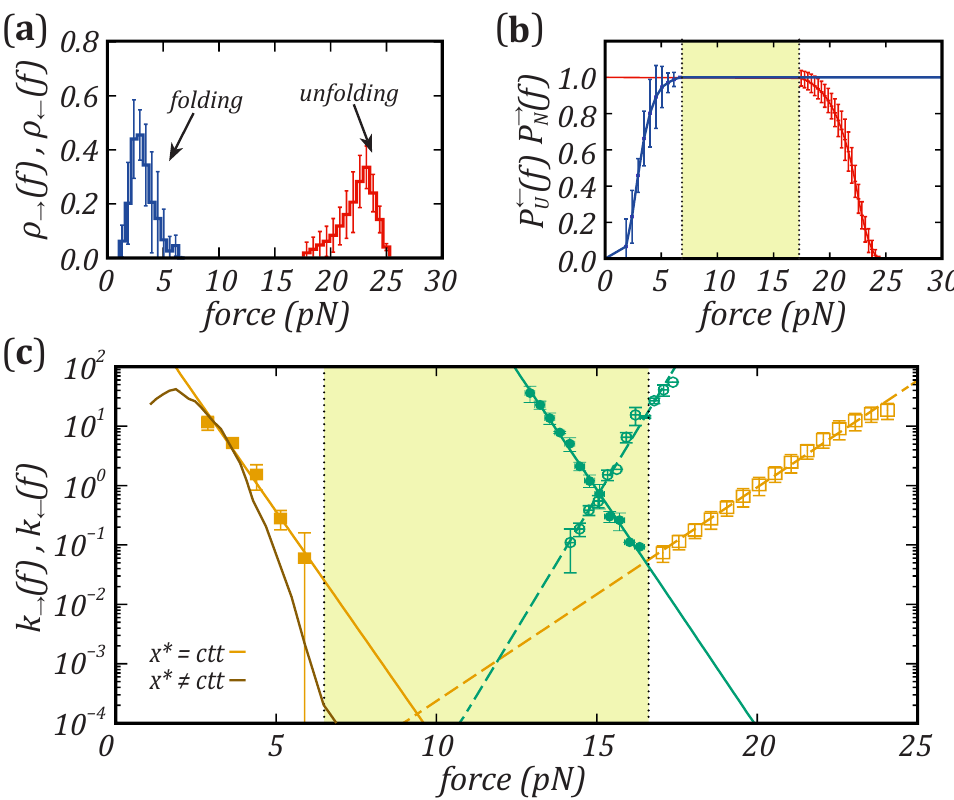
Figure 3. Pulling experiments in barnase at room temperature (298K). ( a ) Barnase unfolding and ( f ) , red symbols) and unfolded folding force distributions. ( b ) Survival probabilities of the folded ( P ← U ( f ) , blue symbols) states. ( c ) Average unfolding (empty symbols) and folding (solid symbols) ( P → N kinetic rates of the DNA hairpin (green) and barnase (yellow). The yellow area highlights the wide range of forces were the kinetic rates of barnase can not be measured. The yellow and green lines are the fits of the kinetic rates to the BE model; the brown line represents the estimation of the folding kinetic rates of barnase, assuming a movement of the TS position with respect to the unfolded state, x ∗ , as discussed in Section 3.2 and shown in Figure